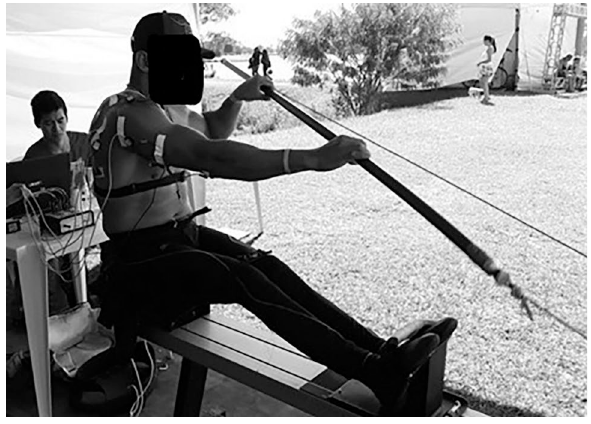
Figure 1 - Parathlete positioned on the ergometer with electromyography signal capture electrodes and heart rate monitor, in the initial position of the